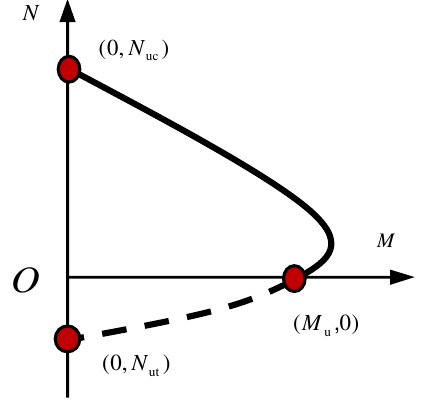
Figure 13. The typical N - M curve.